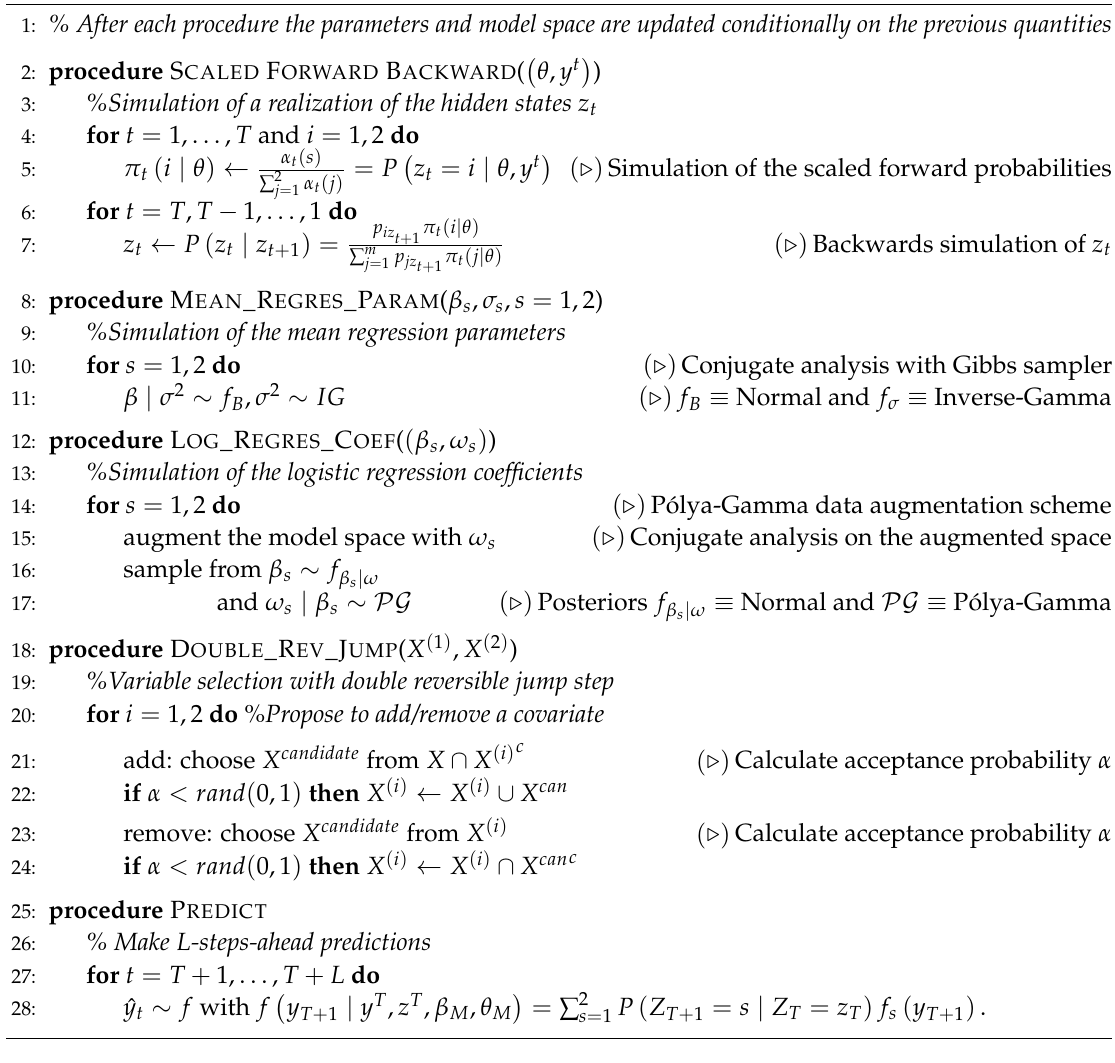
Algorithm 1 MCMC Sampling Scheme for Inference on Model Specification and